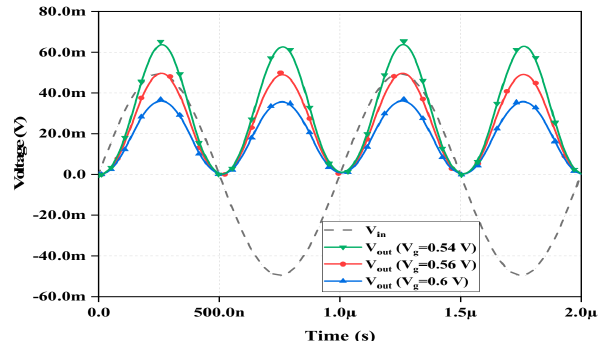
Figure 9. Transient response at frequency f = 1 MHz and V P = 50 mV considering Variable V g .